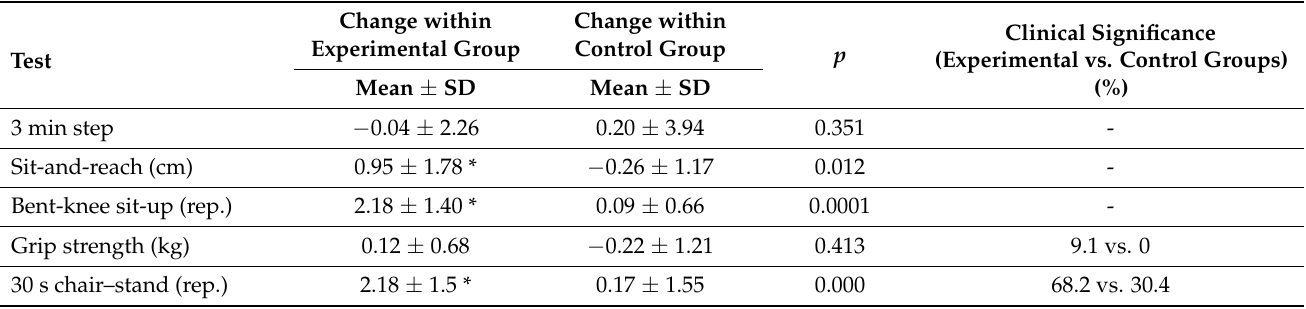
Table 3. The clinical significance of fall prevention and within-group effects with 12-week Pilates program (pre- vs. posttest